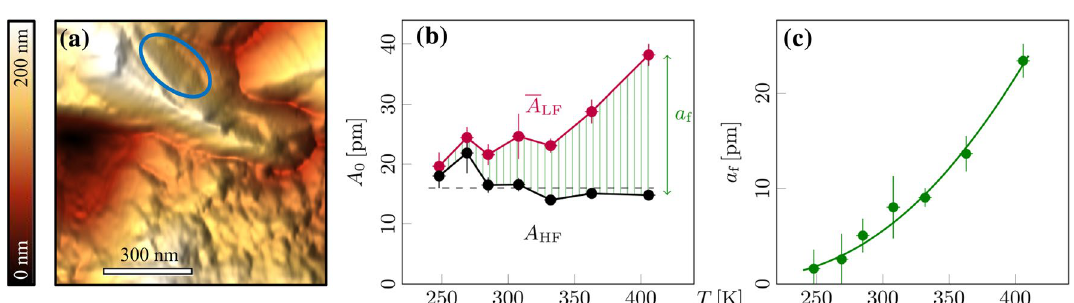
Figure 2. Electrochemical strain microscopy (ESM) on Cu 2 Mo 6 S 8 performed at room temperature with voltages of U AC = 1 V and U DC = ± 1 V. ( a ) Topography, ( b ) average low frequency response A LF , ( c ) high frequency response A HF , and ( d ) the frequency related parameter a f . Three regions have been marked to illustrate different strain related contrast (see main text for details).